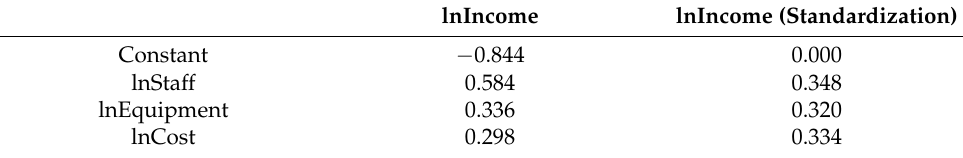
Table 5. Regression coefficients between explanatory variables and explained